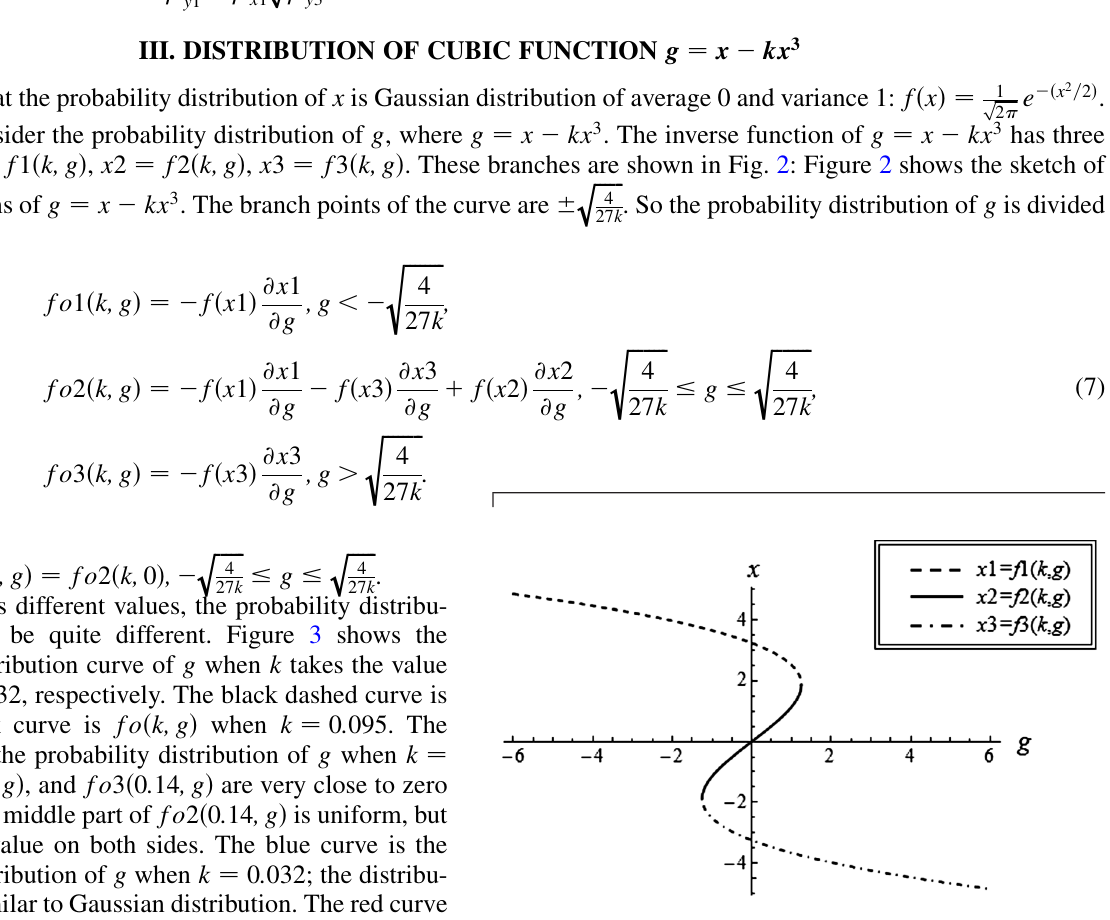
FIG. 2. The sketch of inverse functions of g ¼ x (cid:1) kx 3 . The dashed curve is f 1 ð k; g Þ , the solid curve is f 2 ð k; g Þ , and the dot- dashed one is f 3 ð k; g Þ . The branch points of the curve are (cid:2)